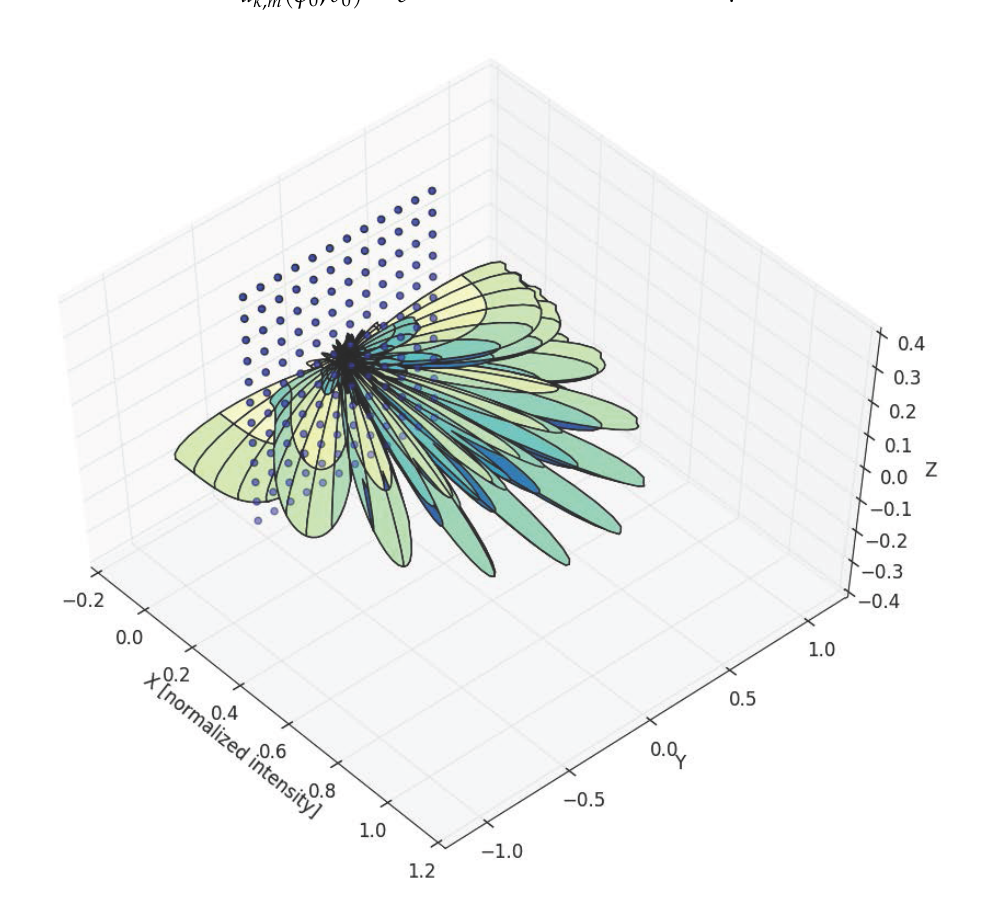
Figure 1. Overlapped plot of Discrete Fourier Transform (DFT) sector